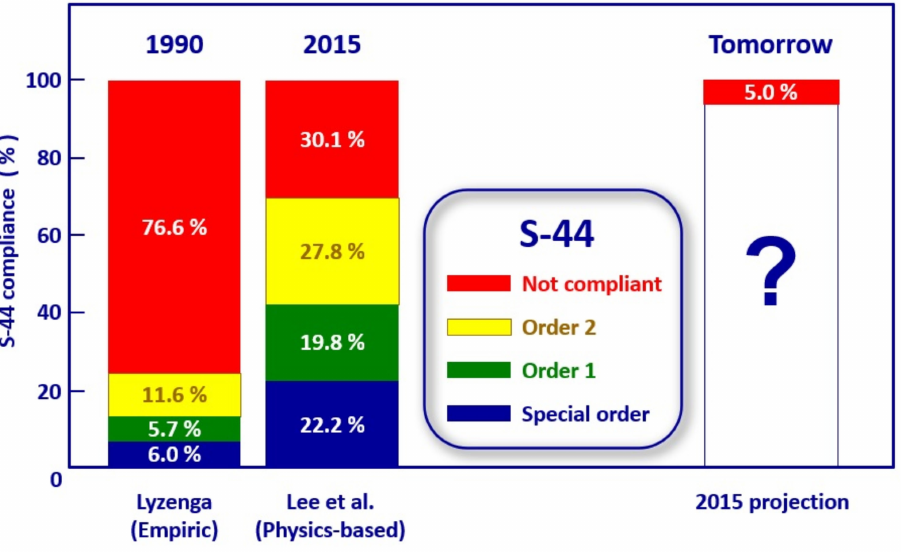
Figure 2. ARGANS 2015 optimistic projection of SDB products compliance with S-44 orders of